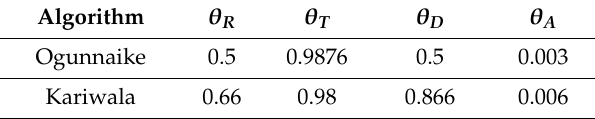
Table 12. Example 2: Tuning parameters with an optimization tool.